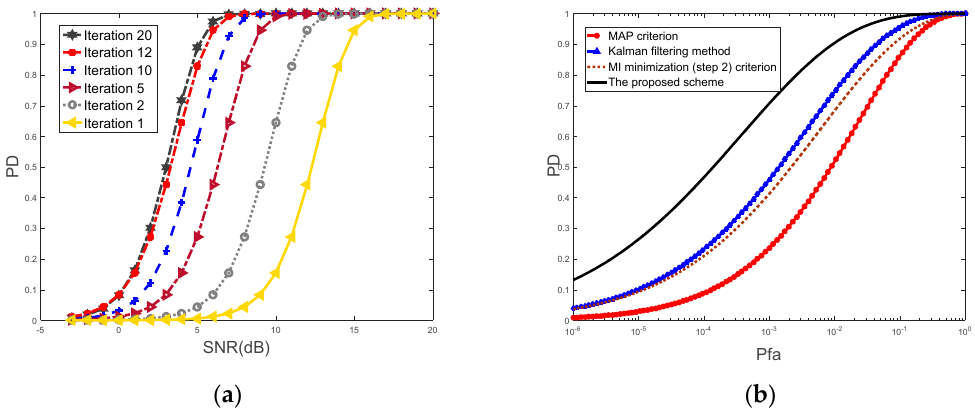
Figure 4. ( a ) The detection probability for different iterations provided by the proposed scheme; ( b ) The receiver operating characteristics (ROC) for four approaches.